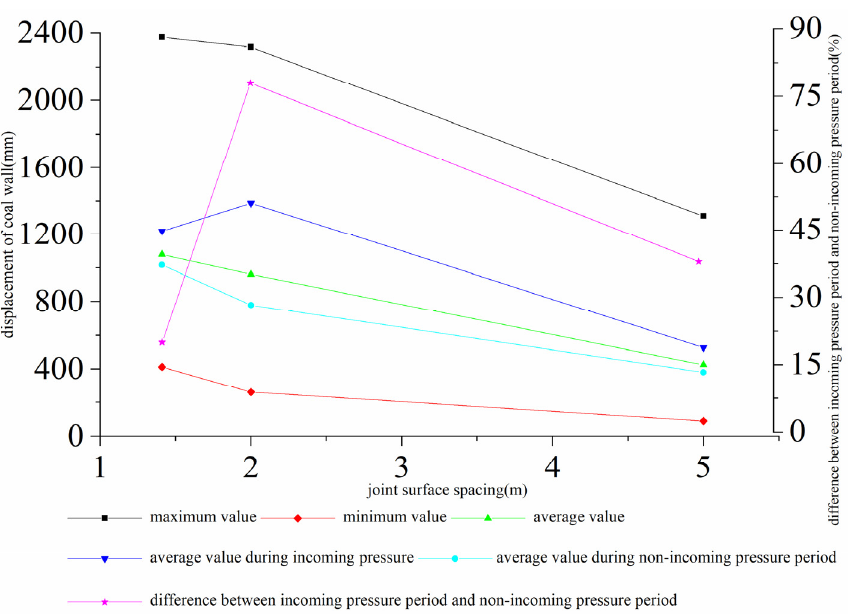
Figure 20. Coal wall Y-displacement change law with joint spacing ( α = 45°). It is worth noting that the average displacement during incoming pressure from the working face is greatest when the joint surfaces are spaced at 2 m apart, due to the relatively small size of the coal masses cut by the joint surfaces in the upper part of the wall during incoming pressure from the working face (Figure 7b), which also indicates from